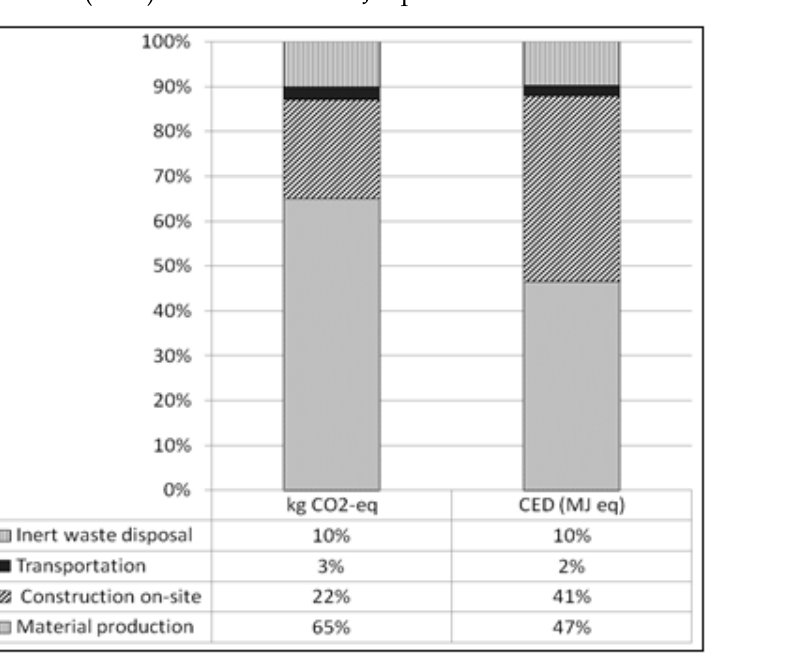
Figure 3. Share of CO 2 -eq emissions and cumulative energy demand (CED) during rock tunnel